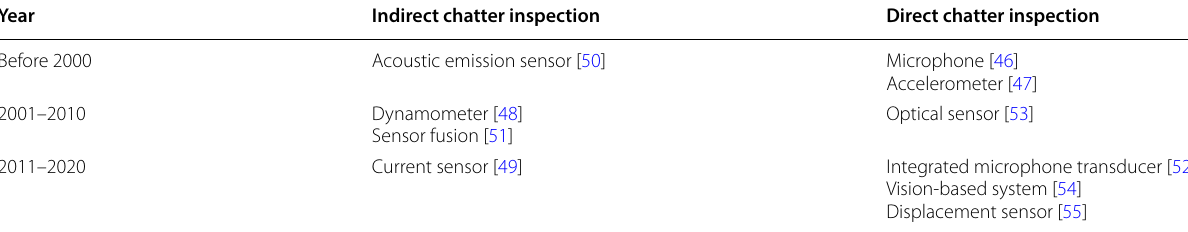
Table 2 Evolution of machining chatter inspection Year Indirect chatter inspection